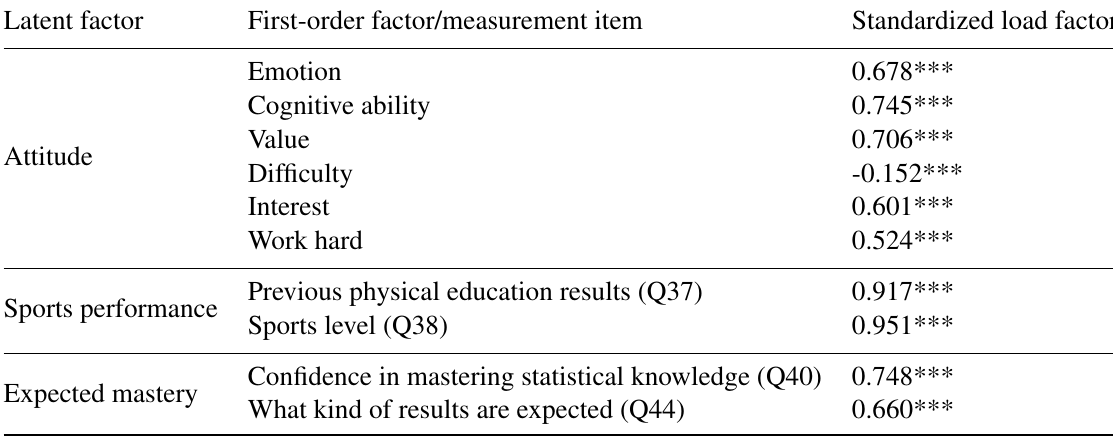
Table 4 Confirmatory factor analysis estimation results.